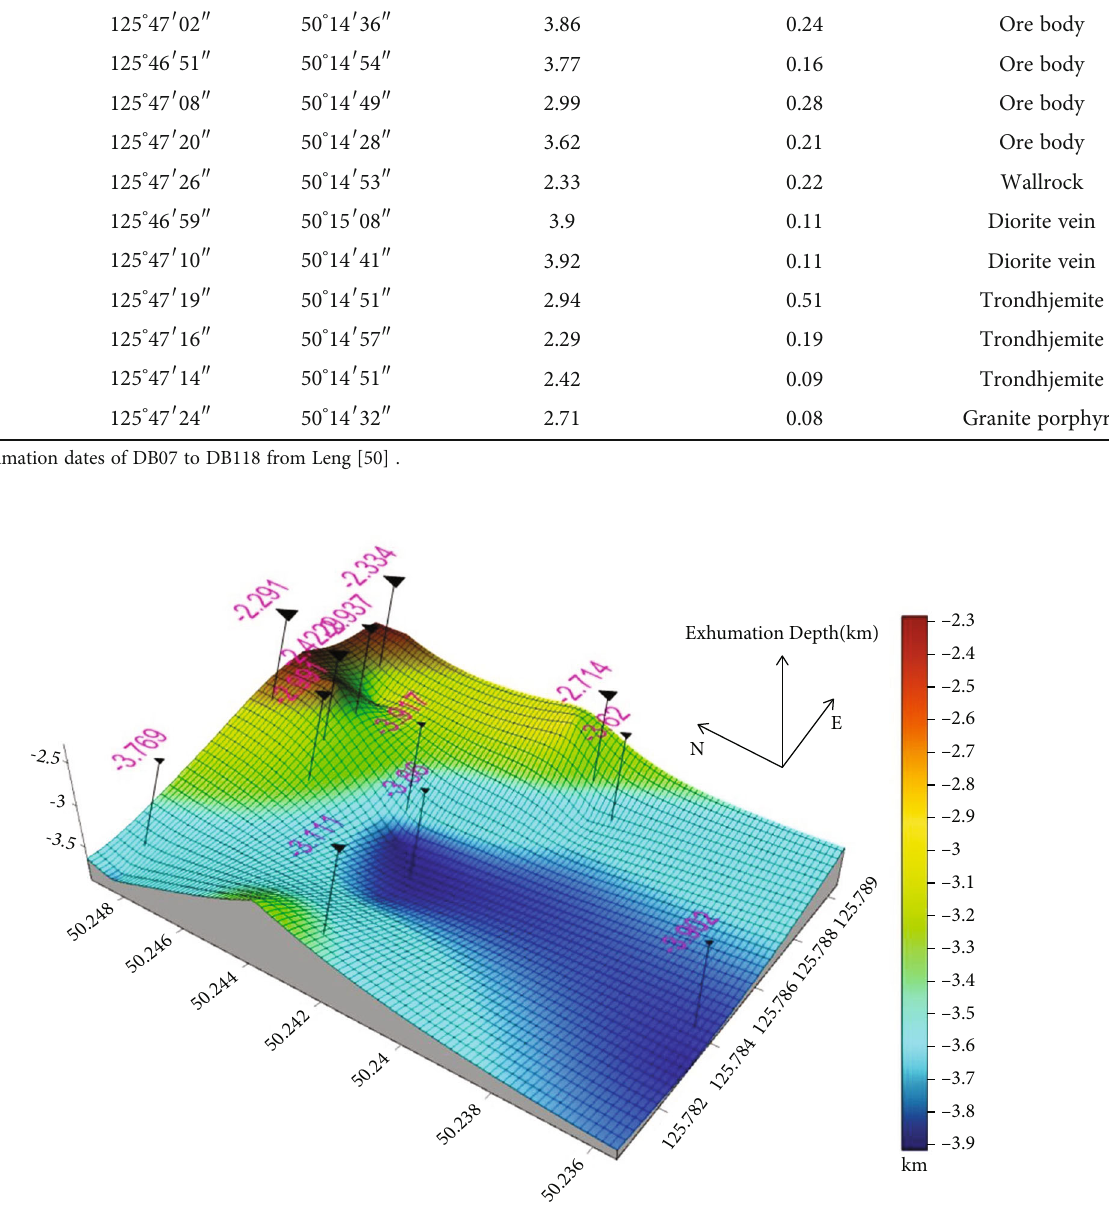
Figure 7: Three-dimensional model of exhumation after the formation of the Duobaoshan copper